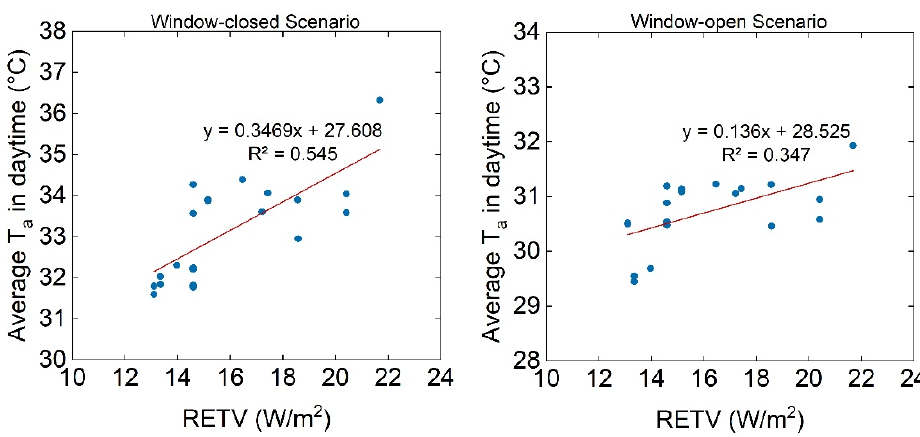
Figure 15. Relationship between WWR and average T a .